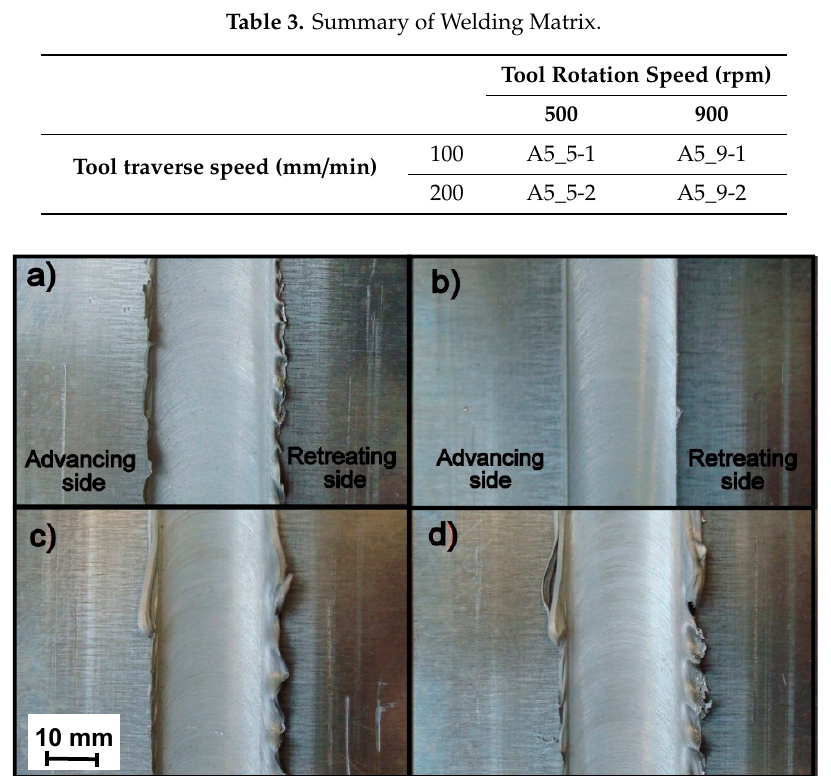
Table 1. Chemical composition of the 5083-H111 aluminum alloy (wt. %). Table 2. Mechanical properties of AA5083-H111 according to the standard and own research.